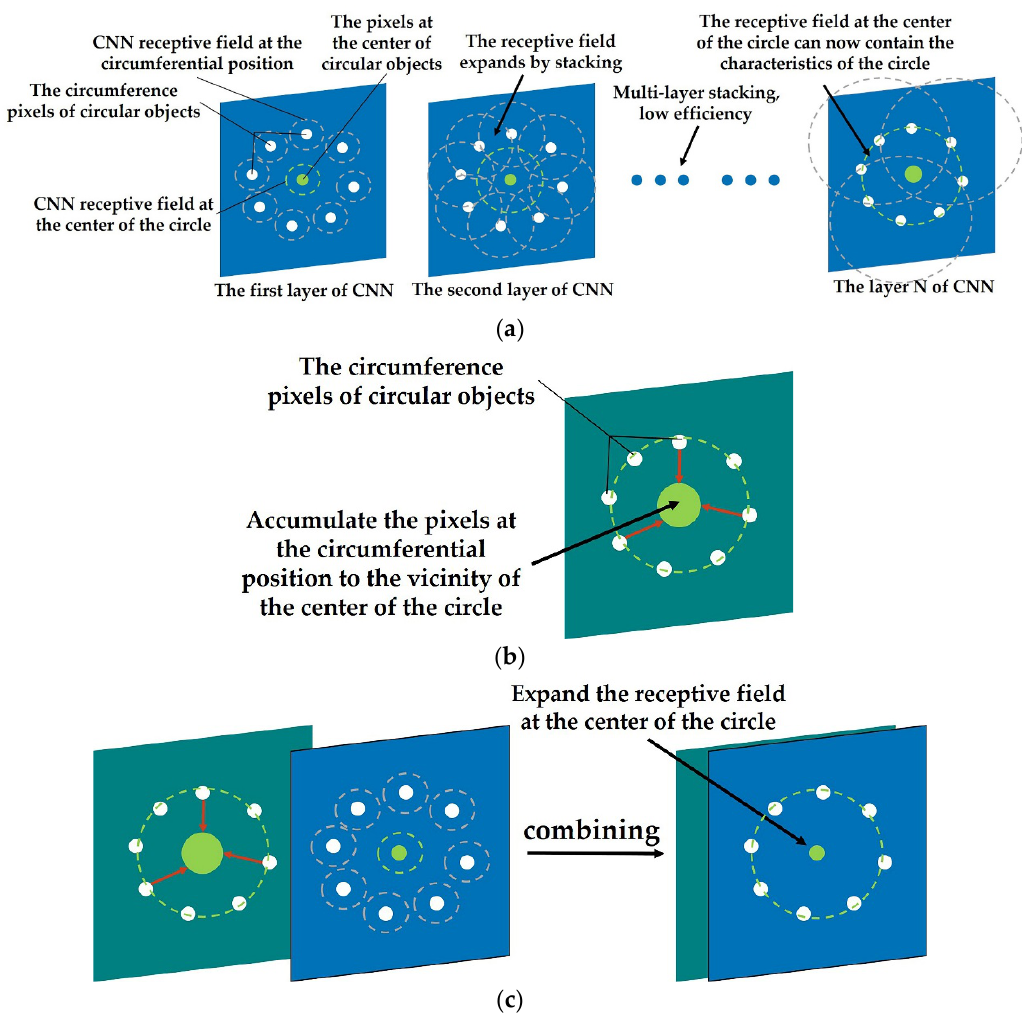
Figure 2. Schematic diagram of CNN, FGMRST/FRST, and dual-channel method applied to circular objects. ( a ) CNN Remote Sens. 2021 , 13 , x FOR PEER REVIEW applied to circular objects; ( b ) FGMRST/FRST applied to circular objects; ( c ) dual-channel method applied to circular objects.